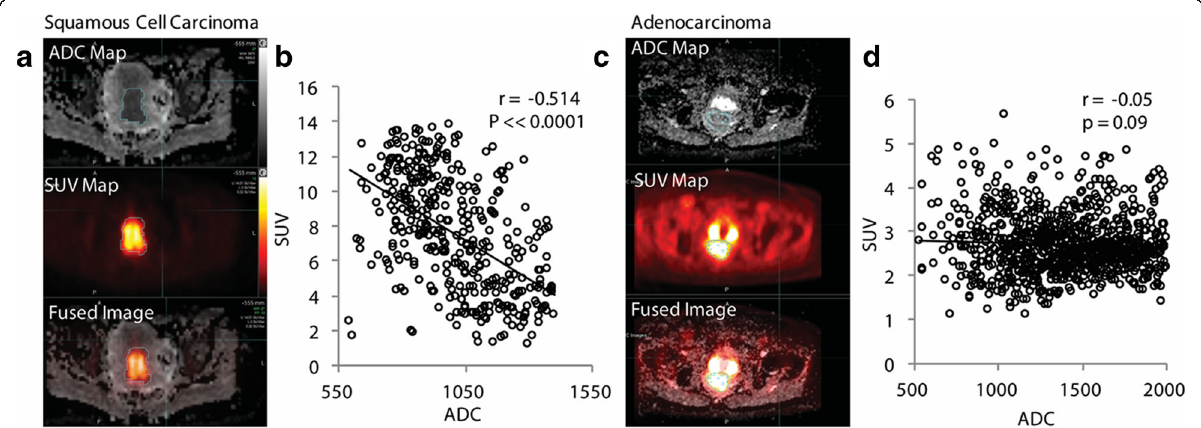
Fig. 2 Representative SCCA tumor ( a ) and the corresponding plot comparing the ADC and SUV of each voxel from the primary tumor ( b ). A representative AdenoCA tumor ( c ) and its corresponding plot comparing ADC and SUV ( d ) are also shown. Most SCCA tumors showed a correlation between voxel ADC and SUV values, whereas most of the AdenoCAs did